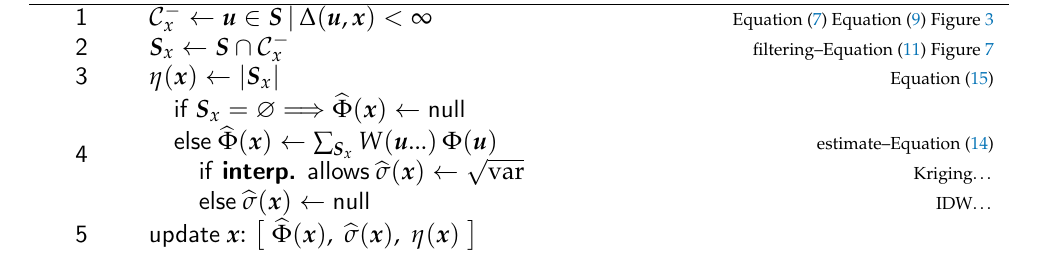
Table 1. Target events’ loop (dashed box of figure